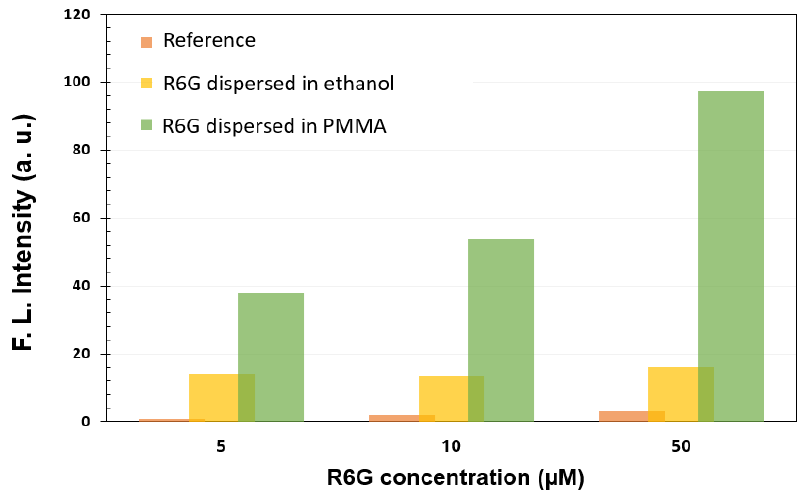
Figure 10. PMMA influence on FLEN.